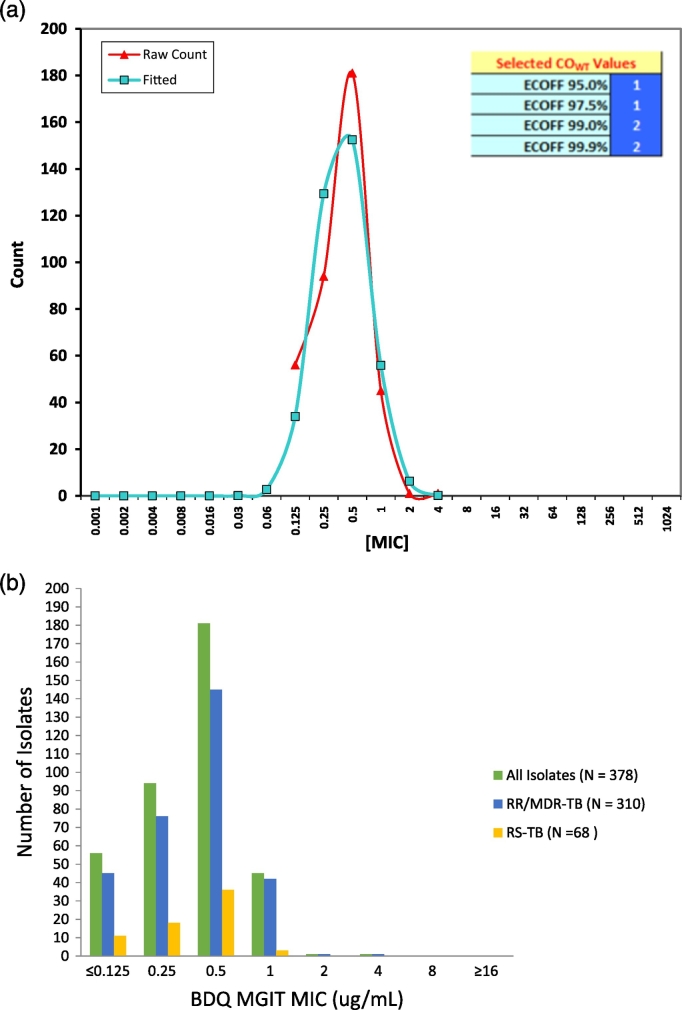
a: Wild-type ECV estimation using iterative non-linear regression on expanding subsets for BDQ on MGIT (N = 378). b: Histogram of BDQ MGIT MIC distribution (μg/ml), N = 378.